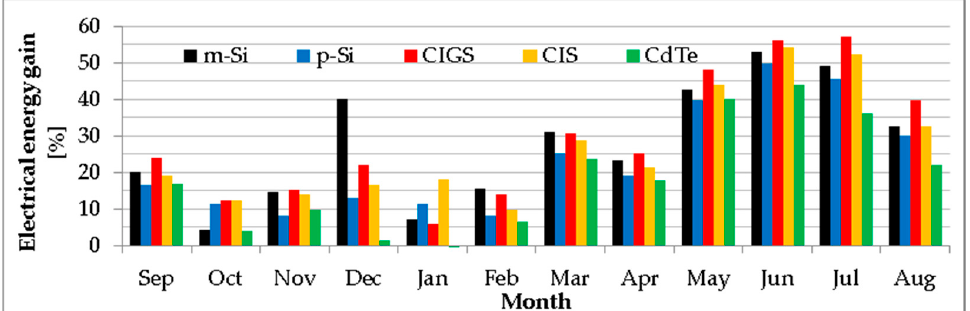
Figure 21. Monthly relative electrical energy gain of the tracked vs. fixed PV modules.